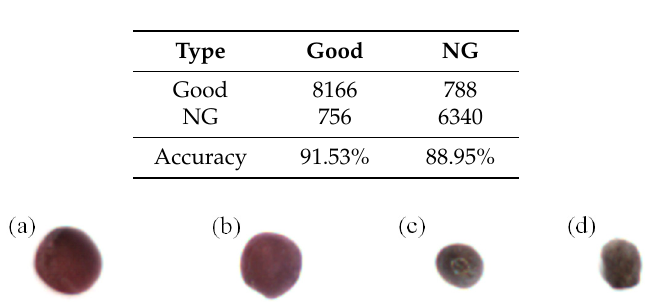
Figure 10. Auto-sorting device for Chinese cabbage seeds. Table 5. Results.